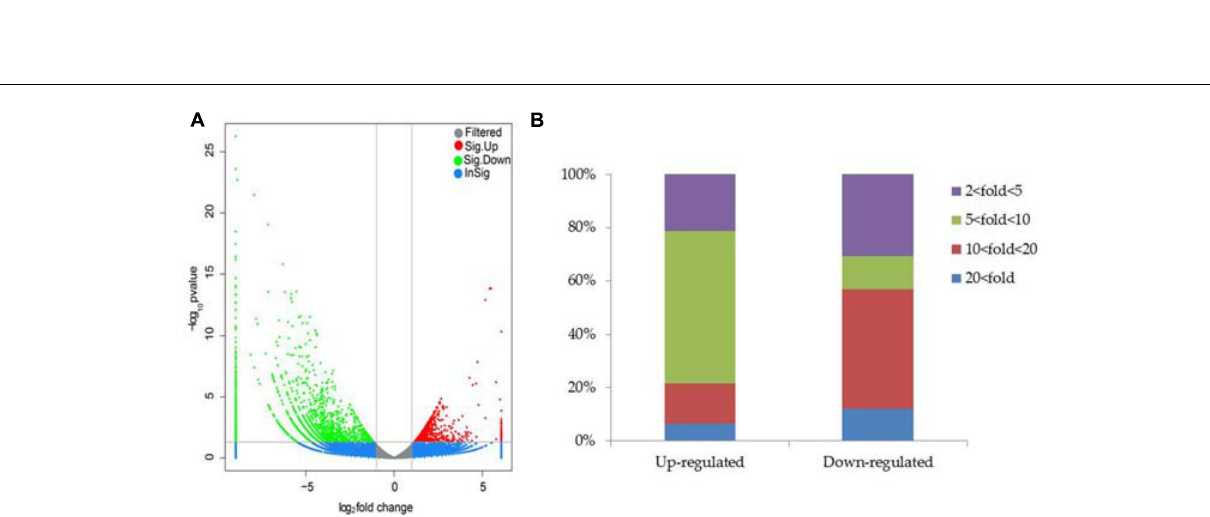
Frontiers in Plant Science |